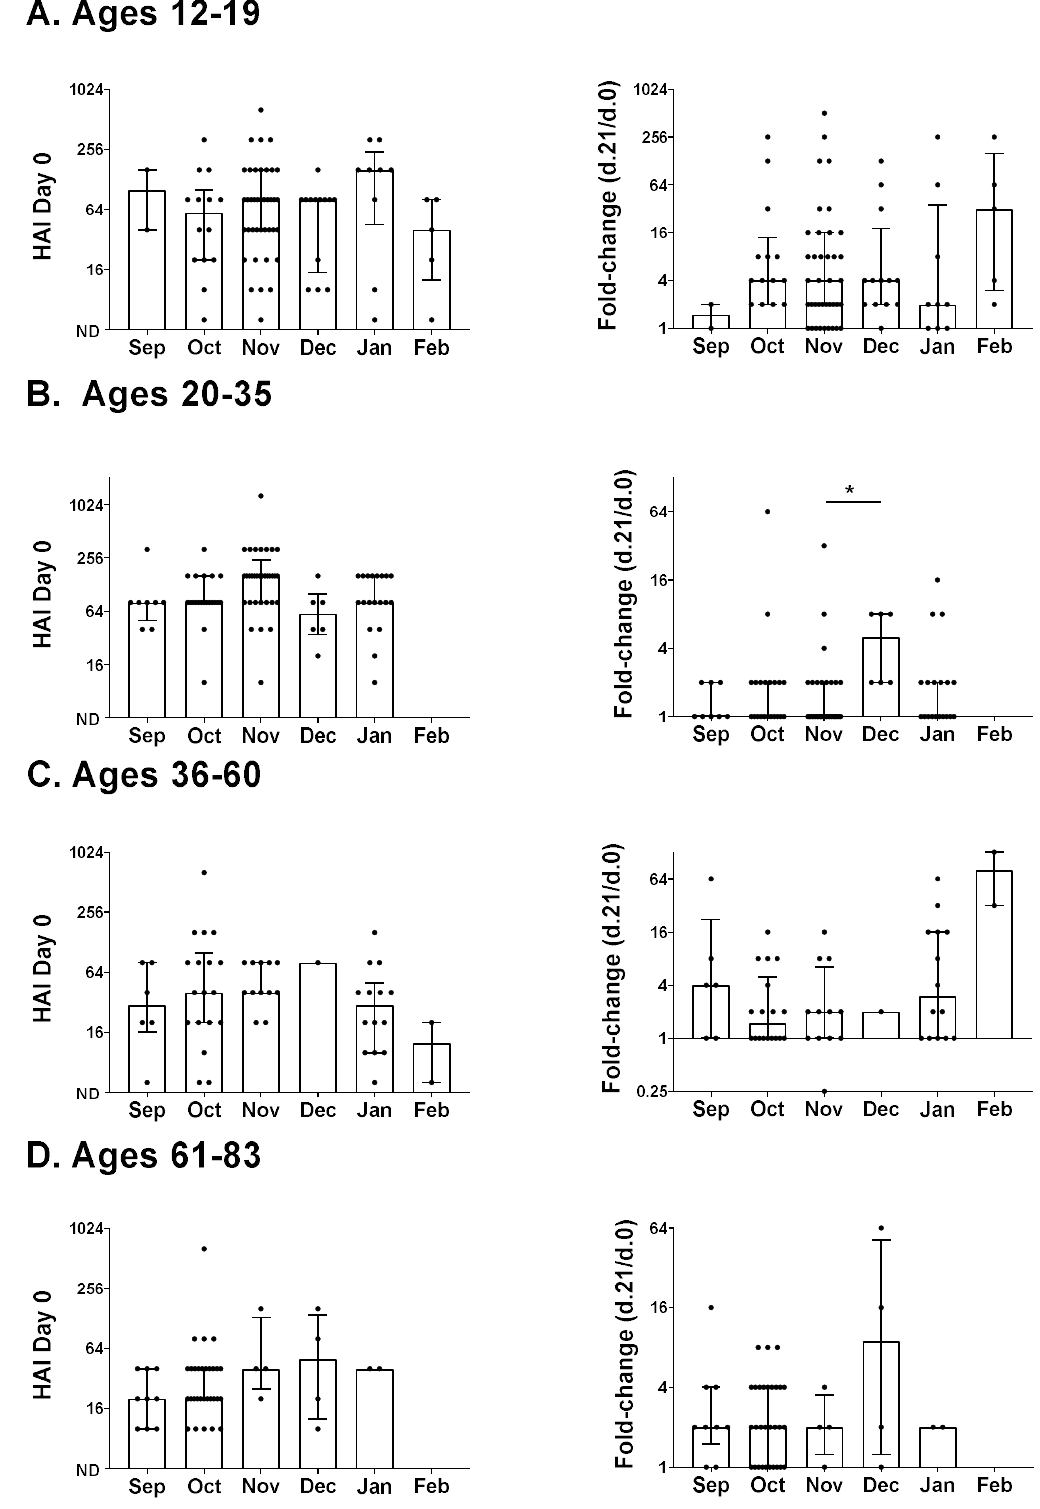
Figure 3. Age and HAI responses by month of vaccination in an adolescent/adult influenza vaccine study. Baseline HAI titers and fold-change results for the 2017–2018 season for participants categorized by age ( A ). 12–19, ( B ). 20–35, ( C ). 36–60, and 9 ( D ). 61–83, inclusive are shown against the H1N1 virus (A/Michigan/45/2015 H1N1). Values (presented as dots for each individual) and statistics are as described in Figure 1. Negative scores (ND = not detected) were assigned a value of 5. Statistical significance is indicated with an asterisk (* p <